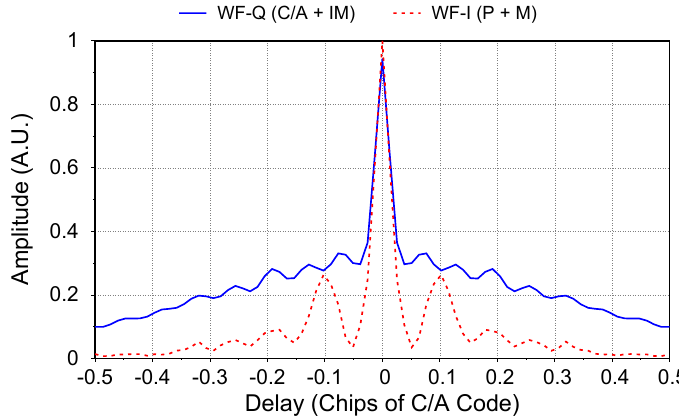
Figure 4. Measured direct waveforms of the GPS L1 in-phase and quadrature components from PRN01. Coherent integration time of T c = 10 ms and incoherent integration time of T inc = 1 s have been used in this example.